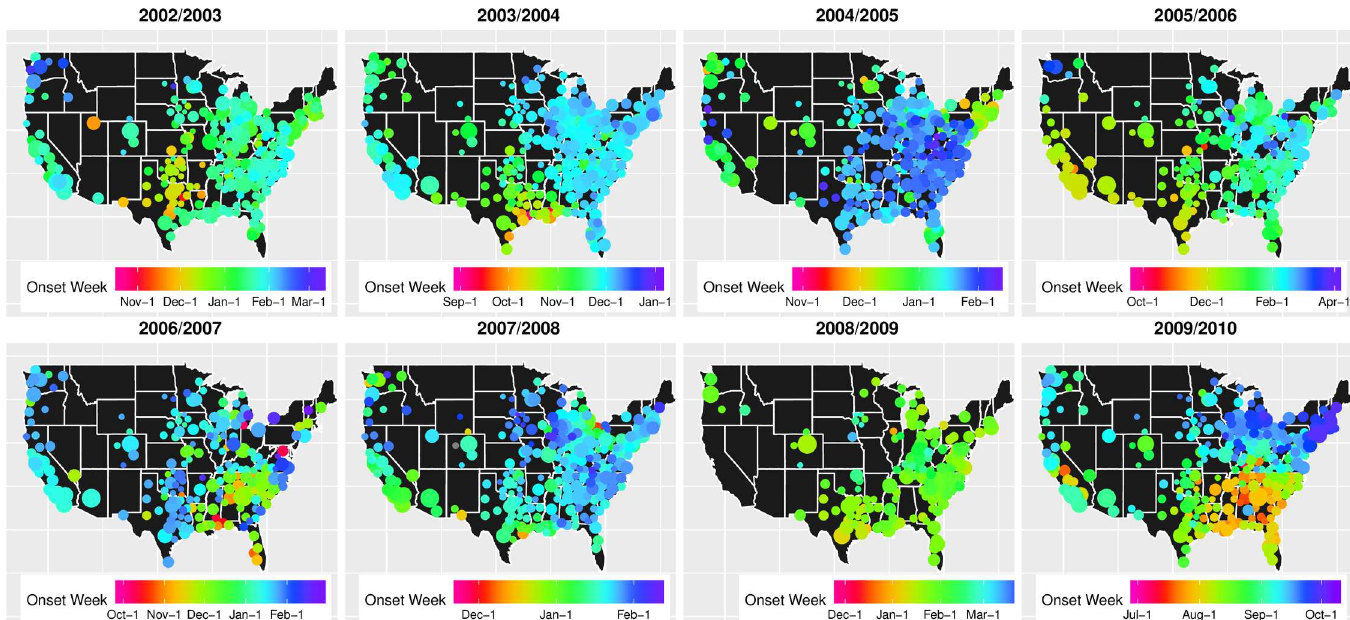
Fig 3. Influenza epidemic onset times across eight seasons, 2002/2003-2009/2010(as estimatedbased on outpatient influenza-like-illness time series). Each circle representsa distinct location, and the size of the circle is proportional to the populationsize of the location.The relative orderingof influenzaonsets is depictedin color, magentaindicating locations with earliest onsets and purple indicating locationswith latest onsets.